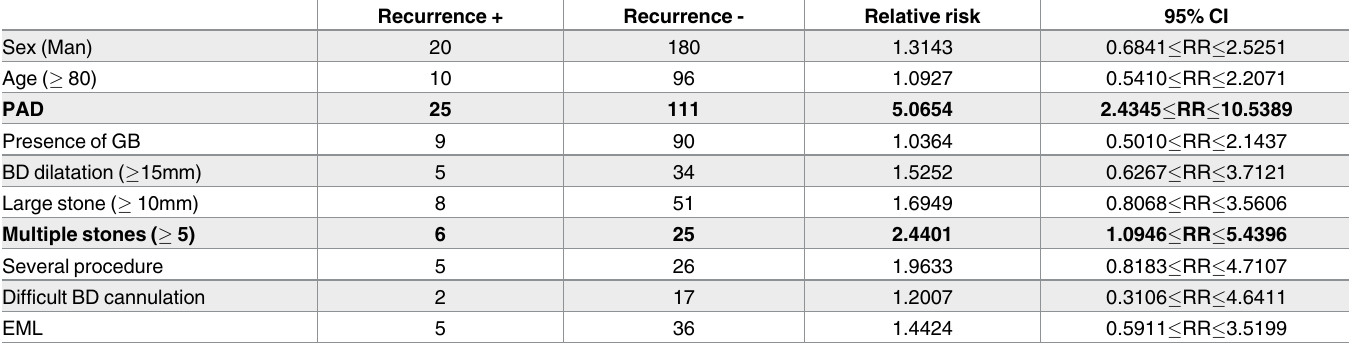
observed in 111 cases among 350 patients (31.7%) without BD stone recurrence (RR, 5.065; 95% CI, 2.435–10.539). PAD types, especially type 1 PAD, significantly correlate with BD stone recurrence (4 patients with recurrence vs. 6 patients without recurrence, p < 0.01). The existence of multiple BD stones ( (cid:21) 5) was also detected as a strong predictor. Multiple stones were observed in 6 cases among cases with recurrence and observed in 25 cases among cases without recurrence (RR: 2.4401; 95% CI: 1.0946–5.4396). Presence of calculus GB, dilated BD, large stones ( (cid:21) 10 mm), using EML were not significant predictors. Logistic regression analy- sis, adjusted for confounders, revealed that the existence of PAD and multiple stones were independent predictors of BD stone recurrence (PAD: OR, 7.768; 95% CI, 3.27–18.471 and multiple stones: OR, 4.542; 95% CI, 1.49–13.898) (Table 3). Fig 2 demonstrates the Kaplan–Meier analysis for the recurrence free period in patients with or without the significant predictors. The patients groups with PAD or multiple stones showed a significantly shorter period until recurrence compared to the patient group without these predictors ( p < 0.001). The recurrence rate was not distinct regarding the treatment type for major duodenal papilla (Table 4). Seven cases of recurrence were observed in patients after EPBD (7/38), 27 cases of recurrence in the patients after ES (27/292), while 0 case of recurrence in patients after EPLBD (0/20) ( p = 0.105). Table 2. Relative risk for stone